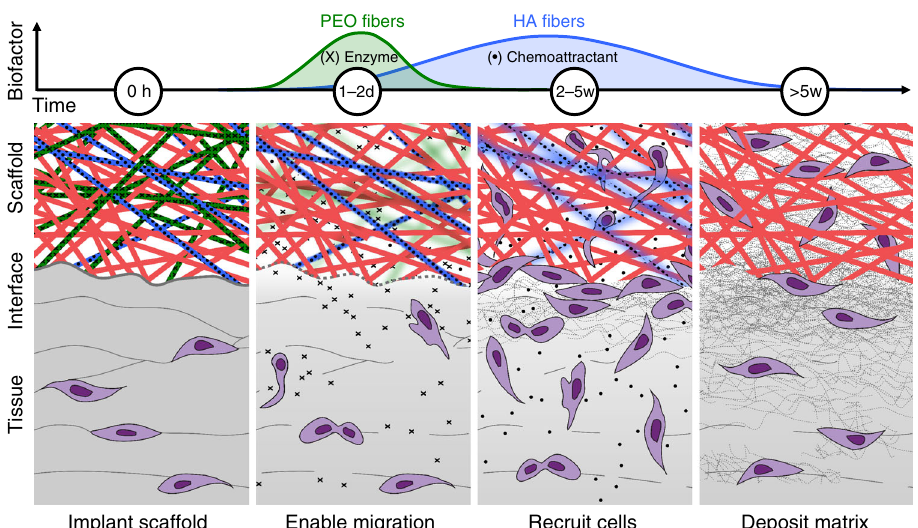
Fig. 8 Reprogramming the wound interface augments dense connective tissue repair. Water-soluble poly(ethylene oxide) (PEO) nano fi bers (green) release a matrix-degrading enzyme (X) in a burst fashion over 24 h, loosening the surrounding matrix and enabling cell migration from the peri-wound matrix to the defect. Controlled release of a chemoattractant ( fi lled black circle) from hyaluronic acid (HA) nano fi bers (blue) over 5 weeks recruits additional cells to the interface and into the scaffold. Dissolution of PEO fi bers and degradation of HA fi bers result in a highly porous scaffold composed of slow-degrading poly( ε -caprolactone) (PCL) nano fi bers (red). Enhanced cell colonization and matrix deposition at the interface and within the scaffold result in